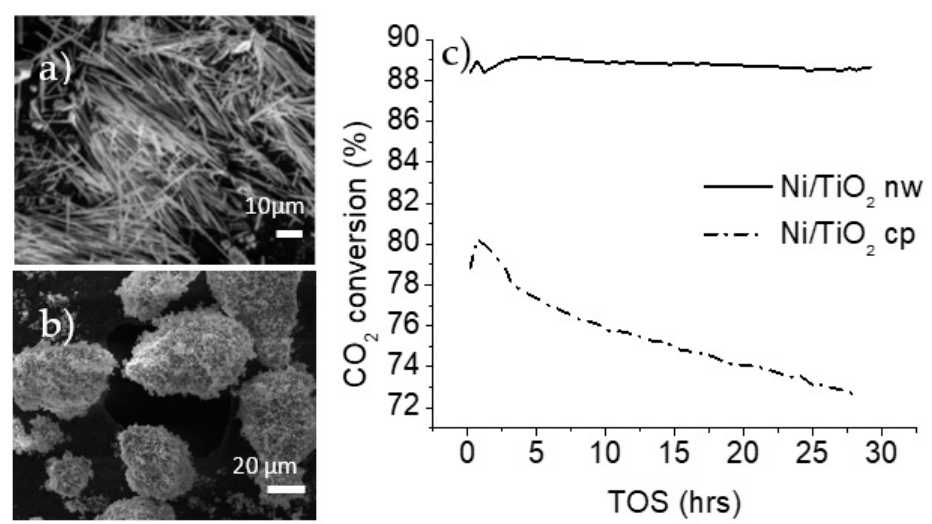
Figure 2. SEM images of ( a ) decorated titania nanowires (nw), and ( b ) decorated titania commercial particles (cp); ( c ) CO 2 conversion during dry methane reforming over titania supports (750 °C, GHSV of 60,000 mlgr − 1 h − 1 , feed ratio of methane to carbon dioxide of 3).